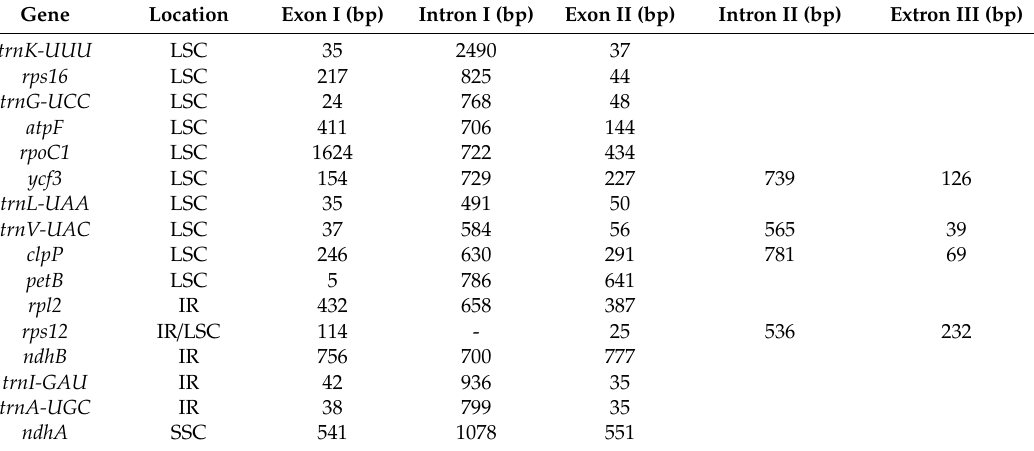
Table 3. Characteristics of the genes that contain introns in the cp genome of Michelia shiluensis .